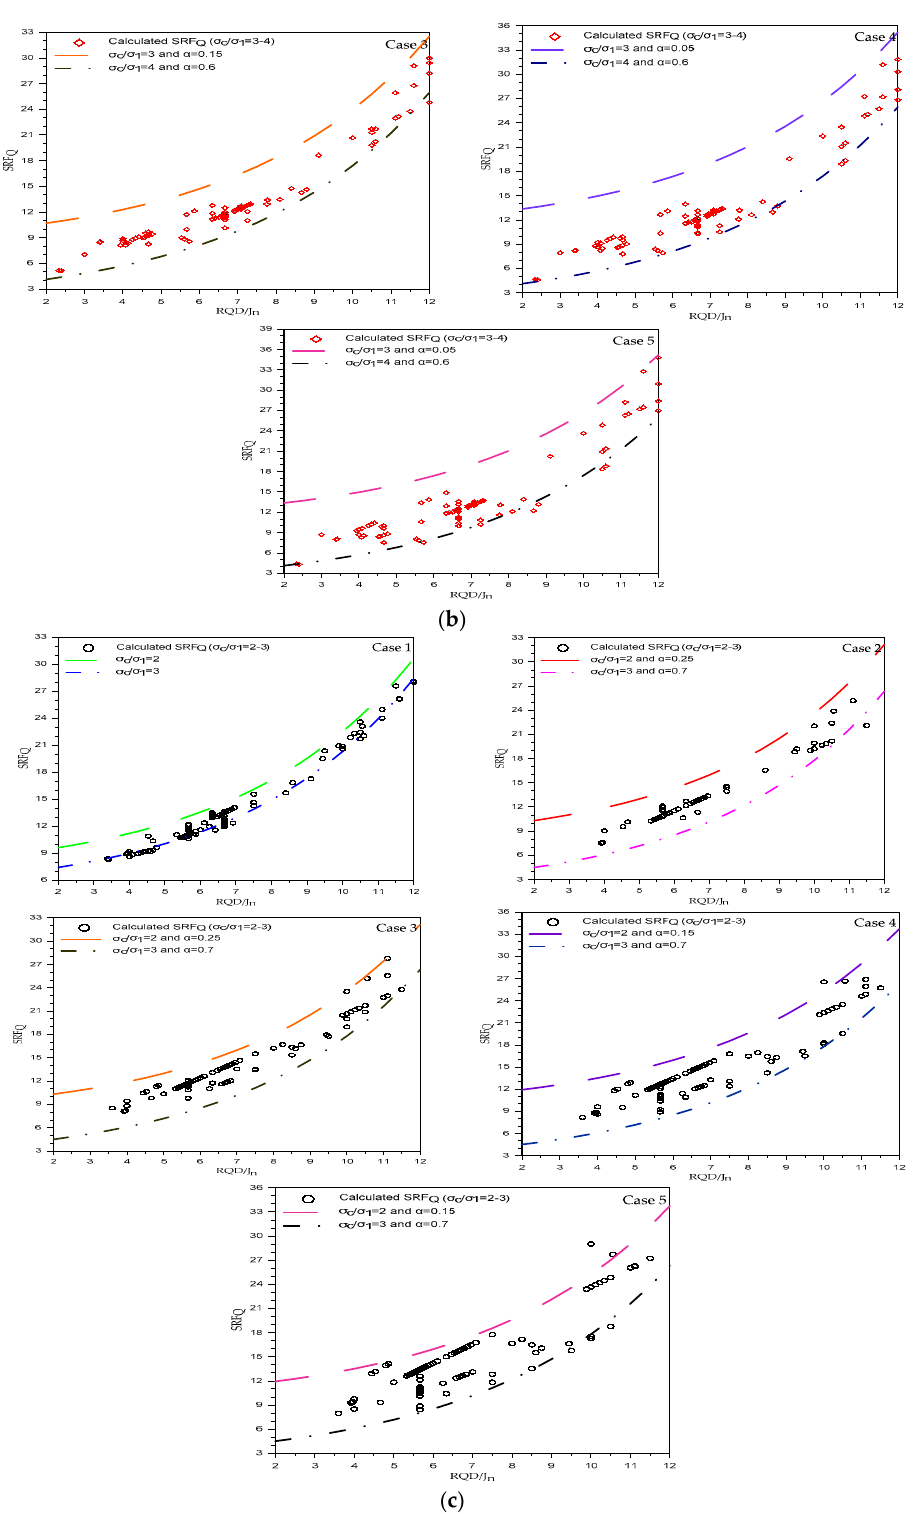
Figure 6. Effect of weightage (Table 6) during back-calculation of rock-mass quality index value (Q*) (Figure 1) in SRF Q versus RQD/Jn plots for different ranges of strength–stress ratio. ( a ) σ c / σ 1 = 4-5, ( b ) σ c / σ 1 = 3-4, ( c ) σ c / σ 1 =2-3.